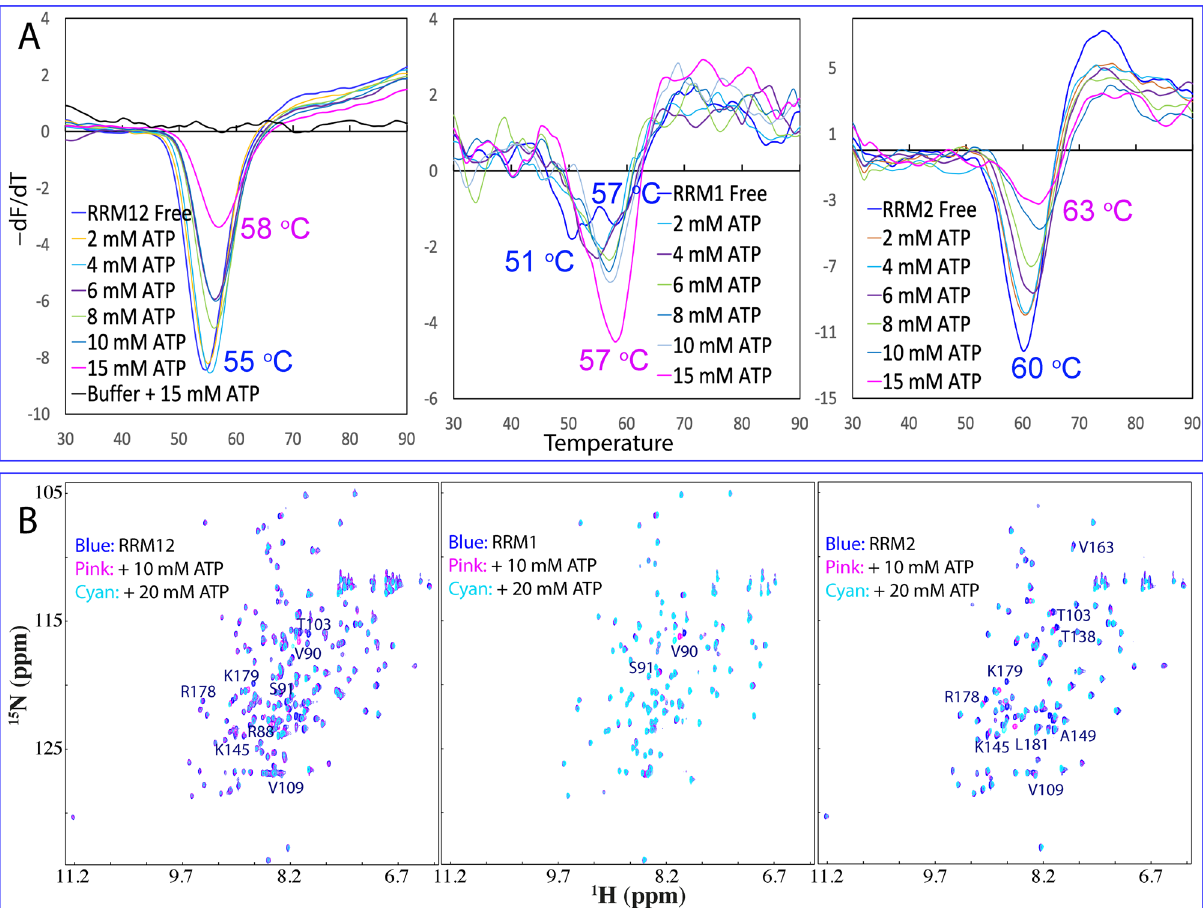
Figure 4. Thermal stability and ATP binding of the hnRNPA1 RRM domains. ( A ) DSF melting curves of thermal unfolding of the tethered RRM1–RRM2, as well as isolated RRM1 and RRM2 domains in the presence of ATP at different concentrations. ( B ) 1 H- 15 N NMR HSQC spectra of the 15 N-labeled tethered RRM1–RRM2, as well as isolated RRM1 and RRM2 domains at 50 μM (blue) in 10 mM sodium phosphate buffer (pH 6.8) containing 150 mM NaCl and 10 mM DTT in the absence (blue), and in the presence of ATP at 10 (pink) and 20 (cyan)